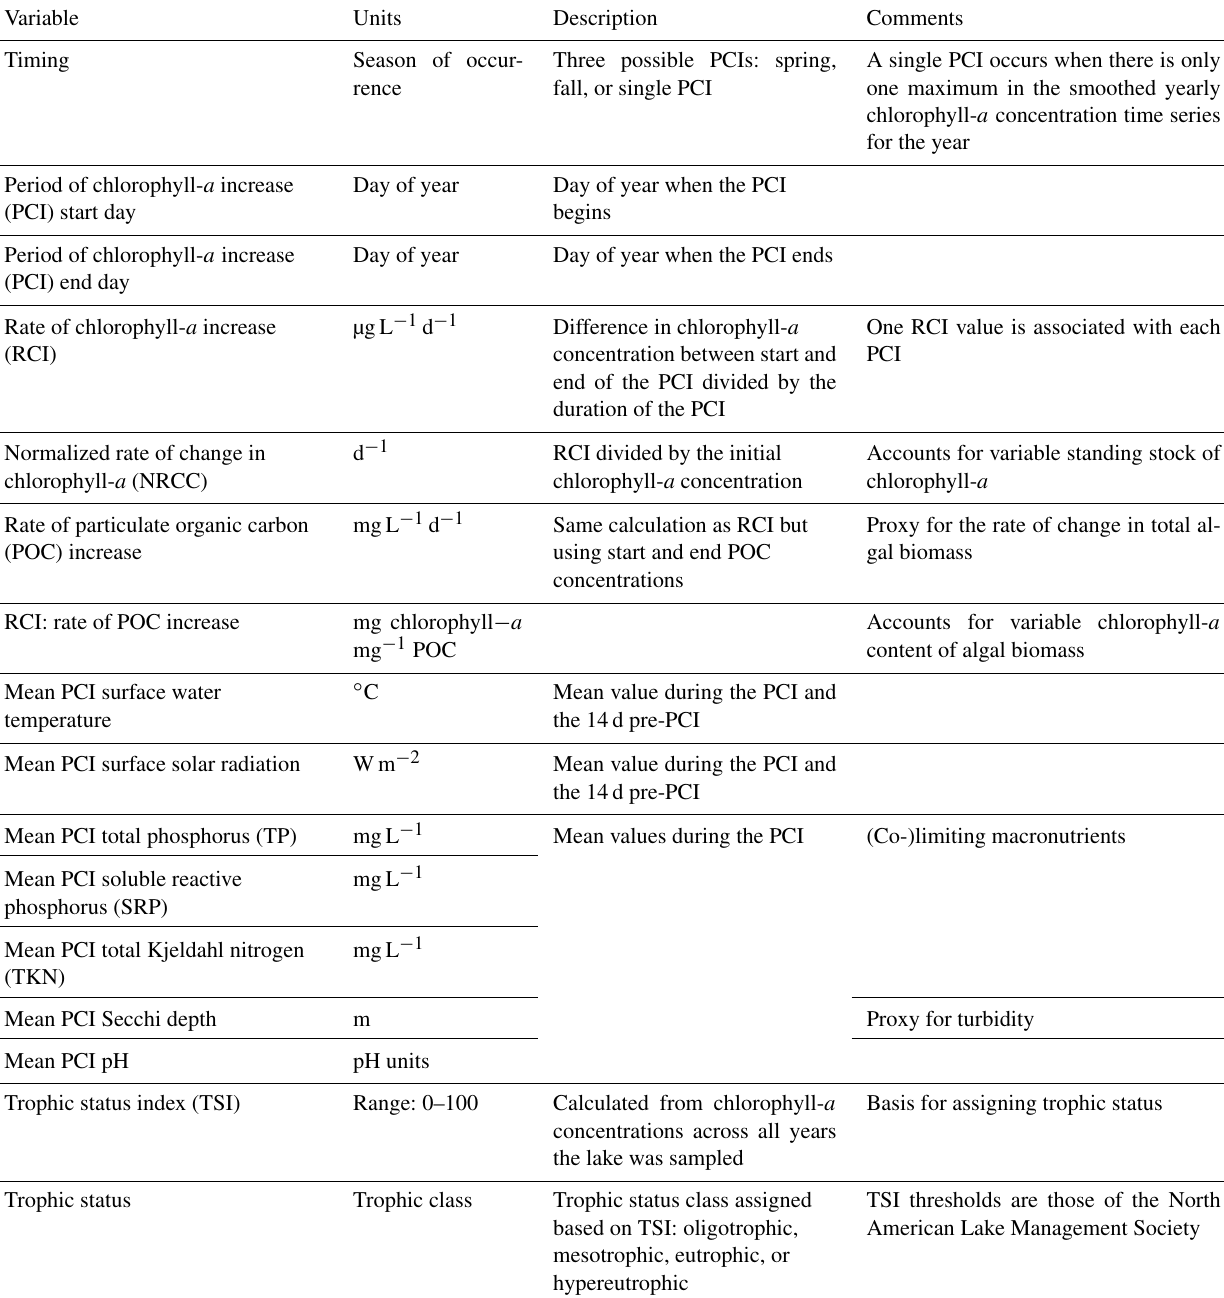
Table 1. Summary of variables in the PCI dataset. Associated lake data (e.g., lake depth, surface area, volume, climate zone) are available in the Appendix (Table